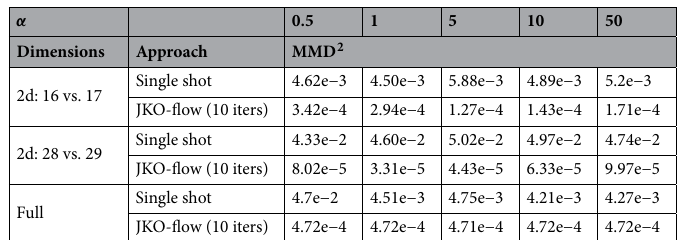
Table 3. Miniboone: comparison of single shot and JKO-flow for different values of α